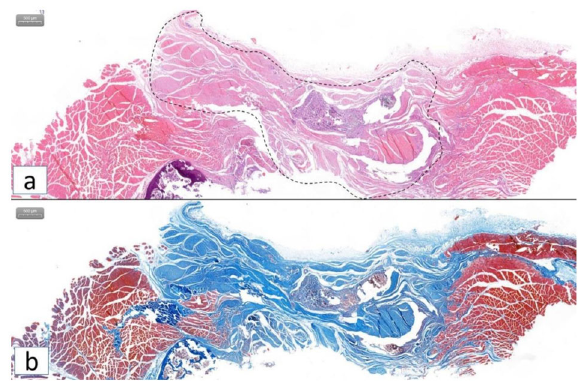
Fig. 5 HE and Masson staining of specimens in ATF group in SD rats. a HE staining and b Masson stating showed that the collagen fi ber structure and the muscle tissue structure were intertwined, and there was no obvious tissue gap, suggesting good tissue healing. Dashed line area indicates the ATF linear material